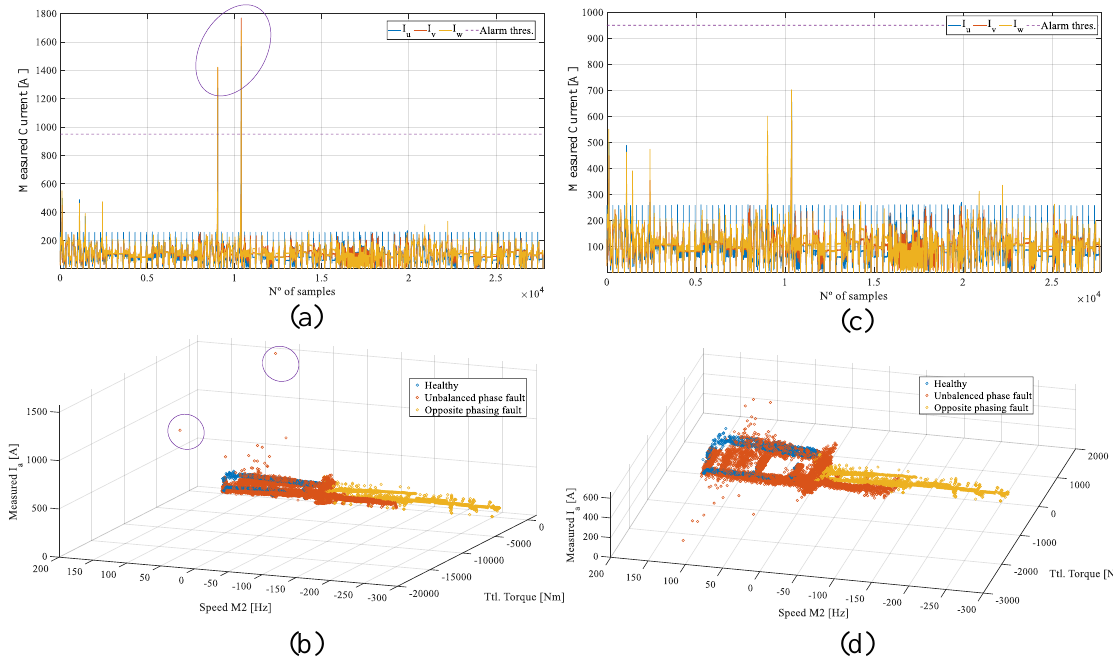
Figure 12. Example of outlier detection tasks. The outliers circled in purple were removed. ( a ) IM phase currents plot with outliers. ( b ) Scatterplot of the raw dataset with outliers. ( c ) IM phase currents plot without outliers. ( d ) Scatterplot of the raw dataset without